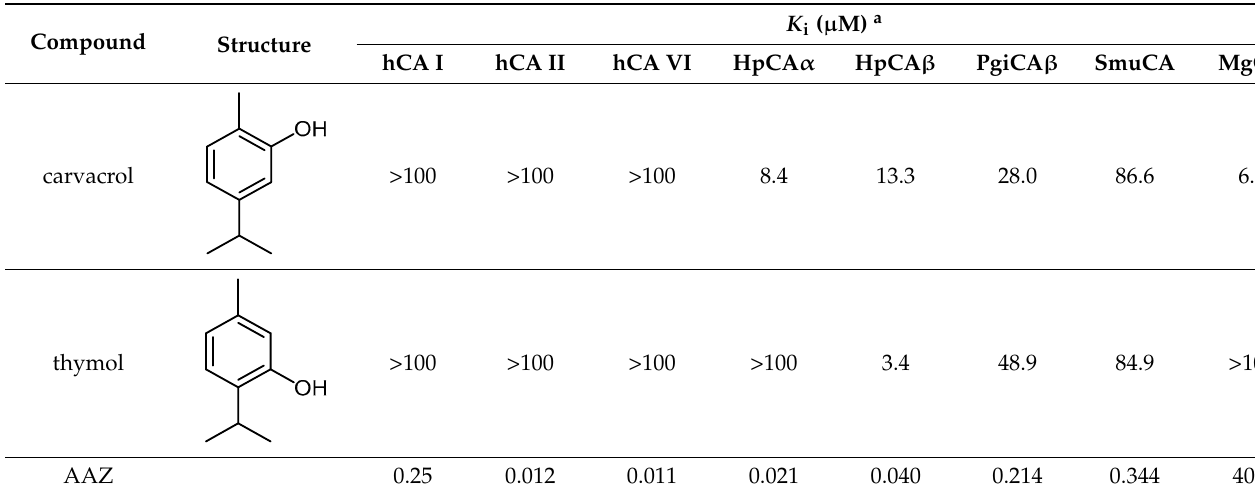
Table 1. Inhibition data of hCA I, hCA II, hCA VI, HpCA α , HpCA β , PgiCA β , SmuCA, and MgCA with the two natural compounds (carvacrol and thymol) and the standard sulphonamide inhibitor acetazolamide (AAZ) by a stopped-flow CO 2 hydrase assay.